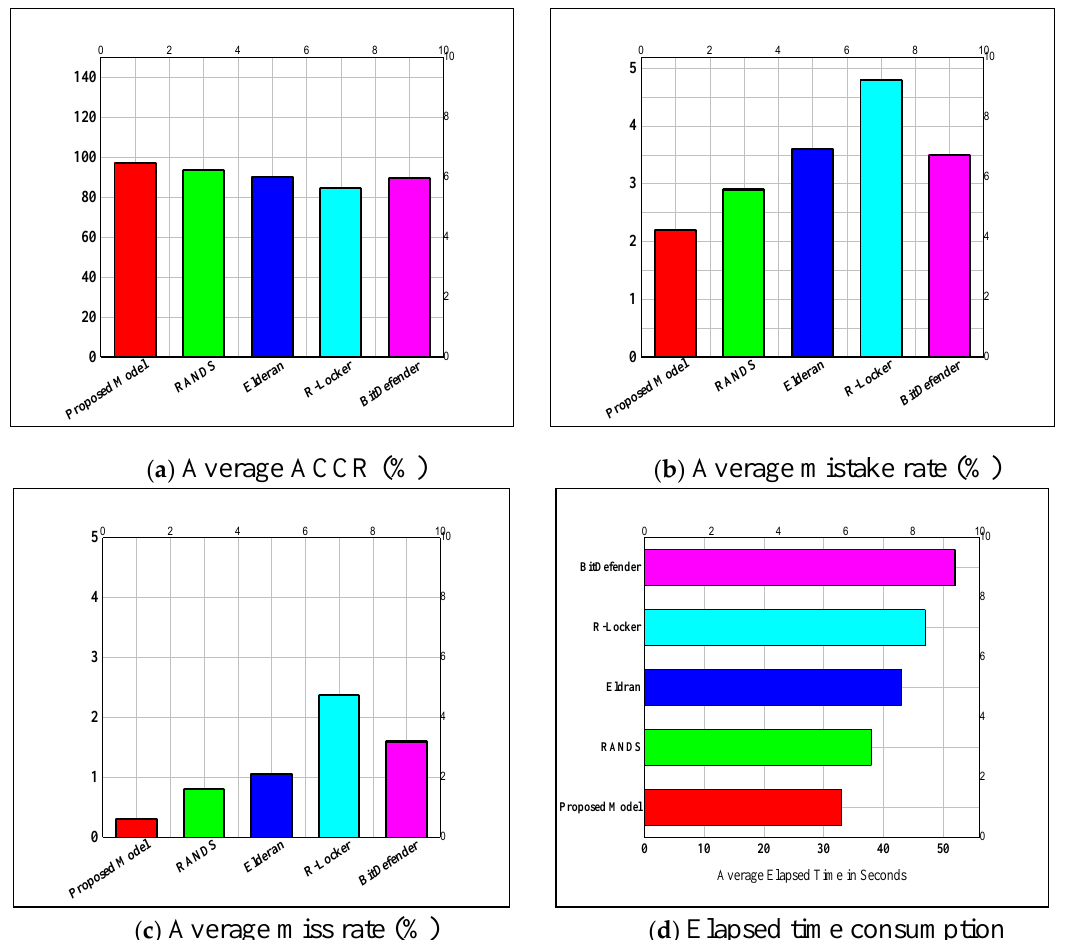
Figure 7. Evaluation of the proposed ransomware streaming analytics model versus different examples of anti-ransomware tools.